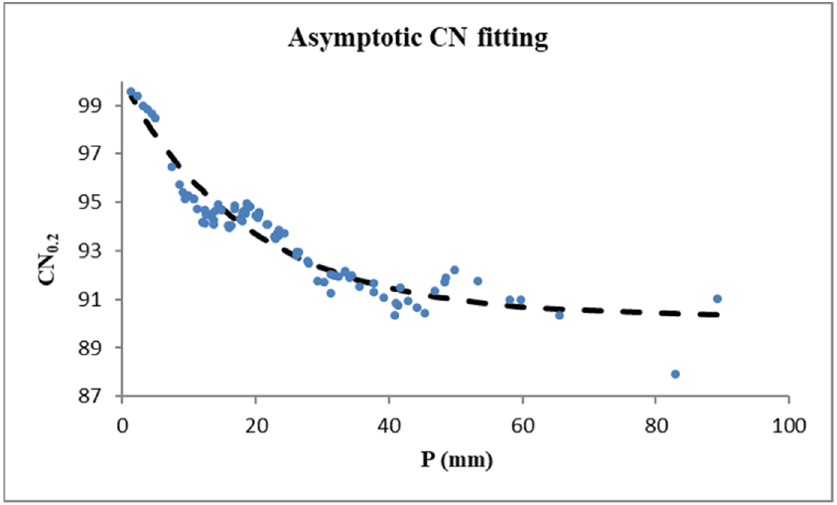
Figure 2. Asymptotic CN fitting of Sungai Kayu Ara watershed: The CN ∞ resembles standard behaviour pattern with CN ∞ = 90 near to stable state at the higher rainfall depths.